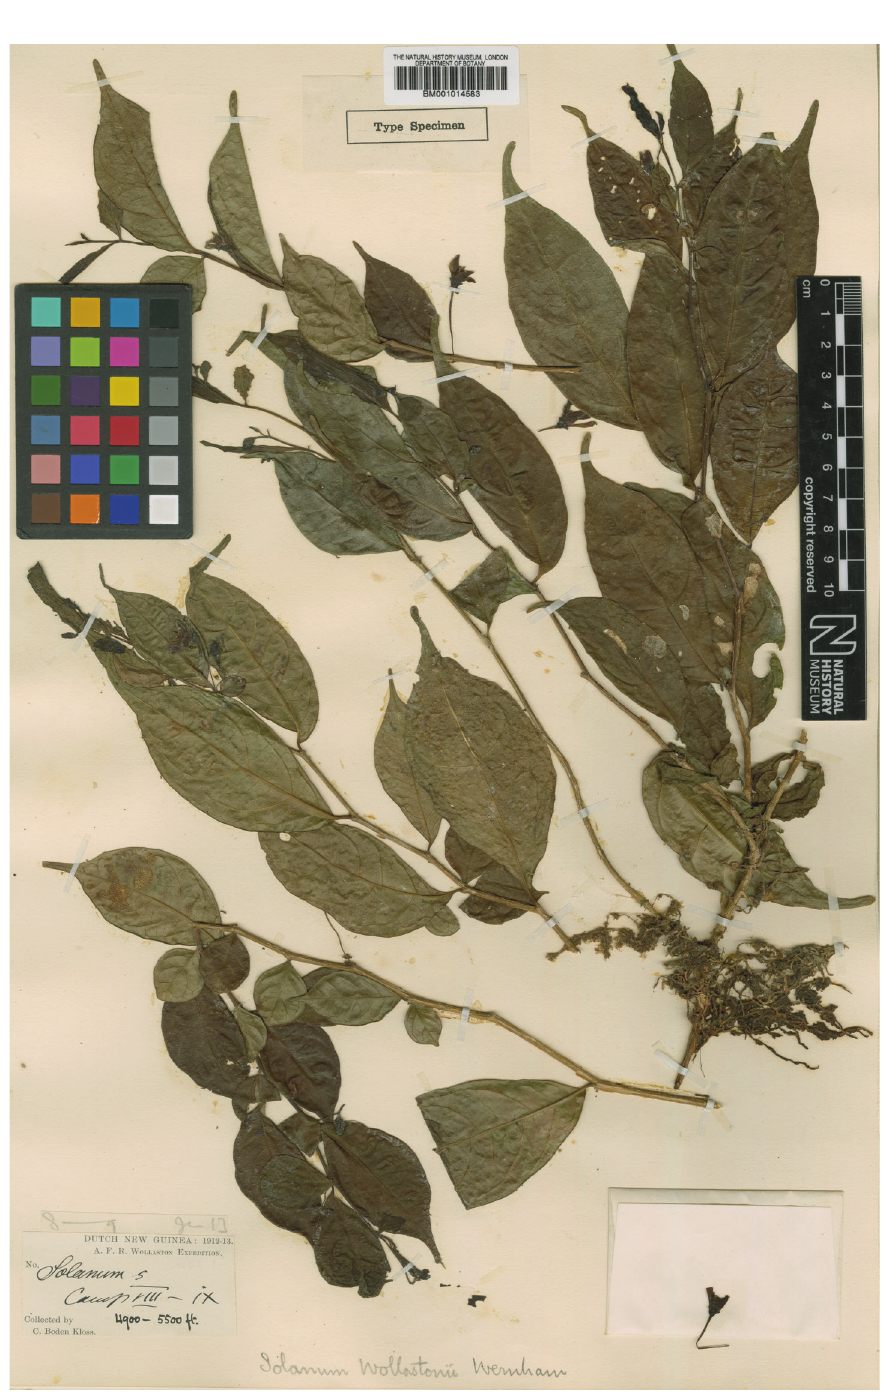
Figure 55. Lycianthes wollastonii herbarium specimen. Indonesia. Papua: Kloss s.n. (holotype of S. wollastonii , BM001014583). Courtesy of the Trustees of the Natural History Museum, London, reproduced with